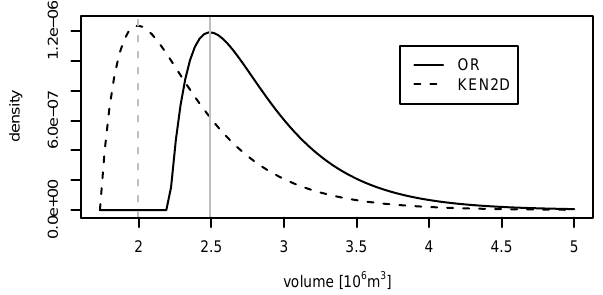
Fig. 9. PDF of V p in the OR and KEN2D ensembles. The most likely design volumes are indicated by vertical